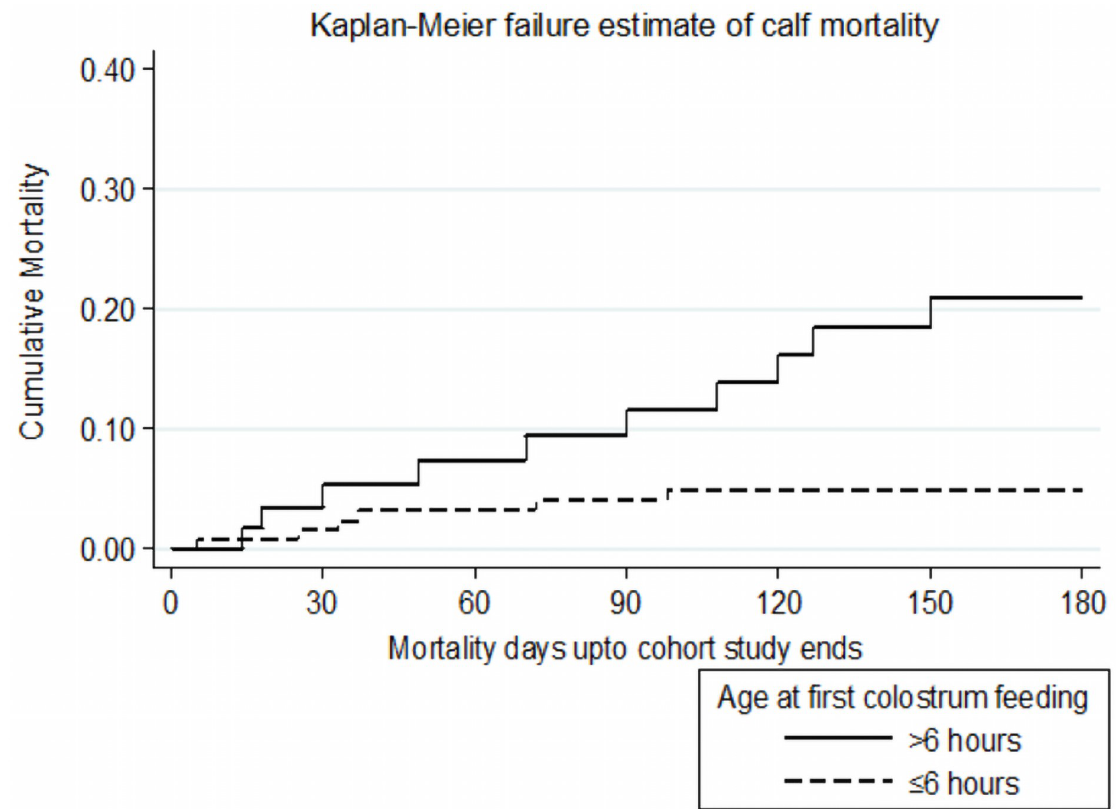
Fig 6. Mortality compared by ages of first colostrum